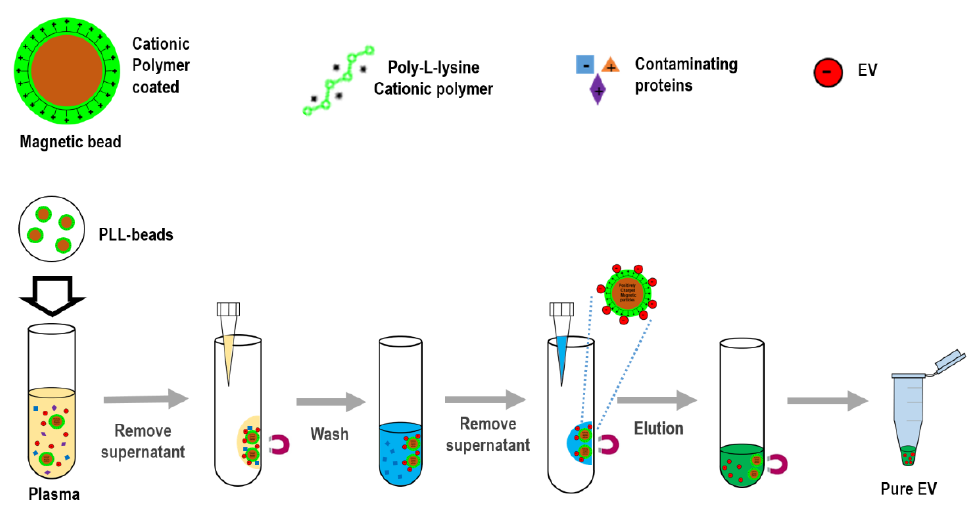
Figure 1. Schematic for extracellular vesicles (EV) isolation using cationic polymer-coated beads. Experimental procedure in which magnetic beads coated with cationic poly-L-lysine (PLL) polymer were mixed with anionic exosomes. Exosome-bound beads were washed and isolated via a magnetic feature.